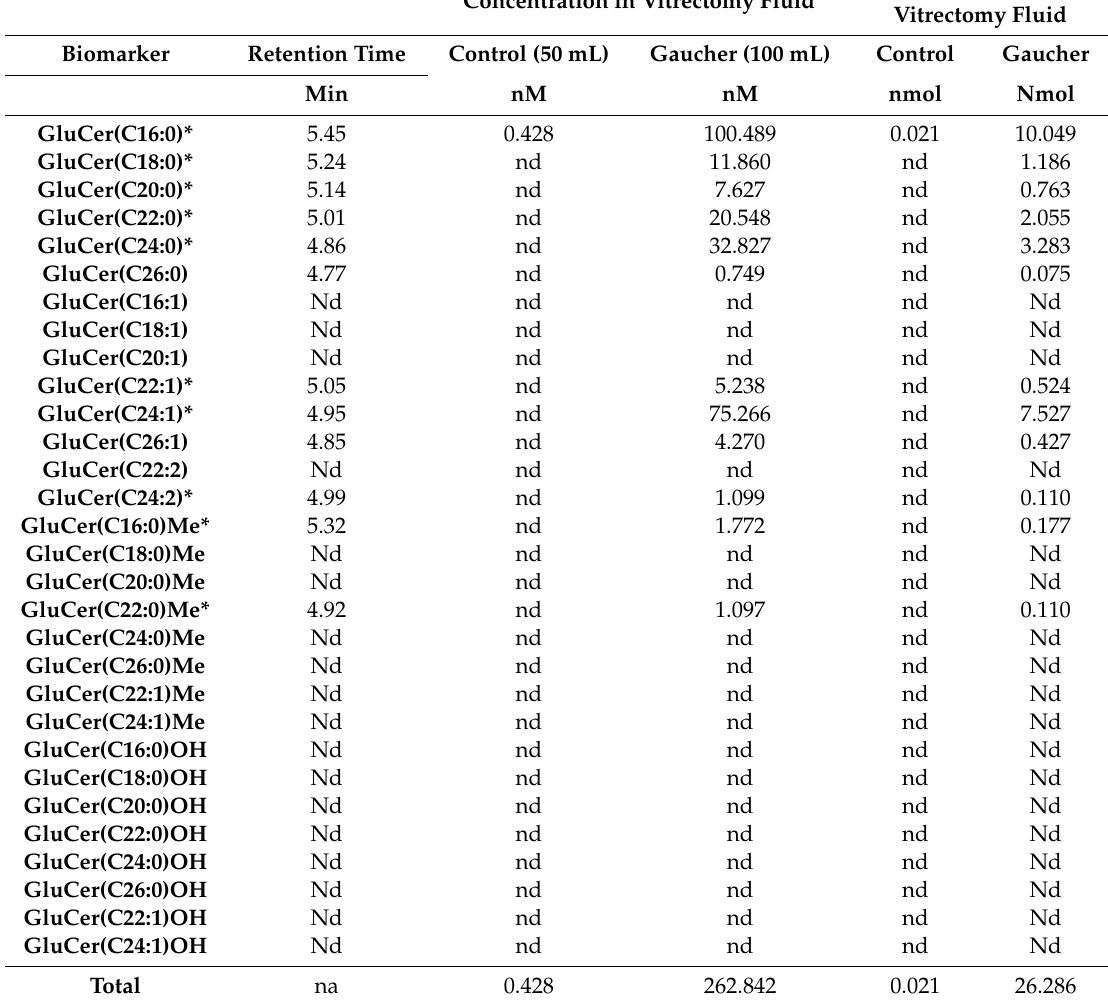
Table 1. Retention time and concentration of 30 glucosylceramide (GluCer) isoforms measured by ultra-high-performance liquid chromatography–tandem mass spectrometry (UPLC-MS / MS) in vitrectomy fluids from a pathological control and from a Gaucher type 3